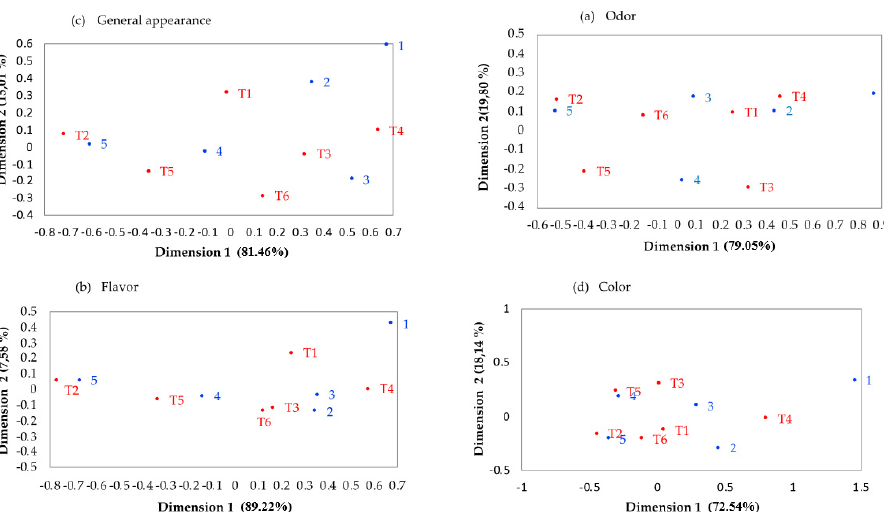
Figure 3. Correspondence analysis of general appearance ( c ), odour ( a ), flavour ( b ) and colour ( d ) of beef hamburgers added to rosemary ( Rosmarinus officinalis ) and garlic ( Allium sativum ) essential oils and chipotle pepper ( Capsicum annum ). T1 = control, T2 = 1% garlic essential oil ( w / w ), T3 = 1% rosemary essential oil ( w / w ), T4 = 0.5% chipotle pepper oleoresin ( w / w ), T5 = 1% garlic essential oil + 0.5% chipotle pepper oleoresin ( w / w ) and T6 = 1% rosemary essential oil + 0.5% chipotle pepper oleoresin ( w / w ); 1: I dislike it a lot; 2: I dislike it little; 3: I don’t like it or dislike it; 4: I like it; 5: I like